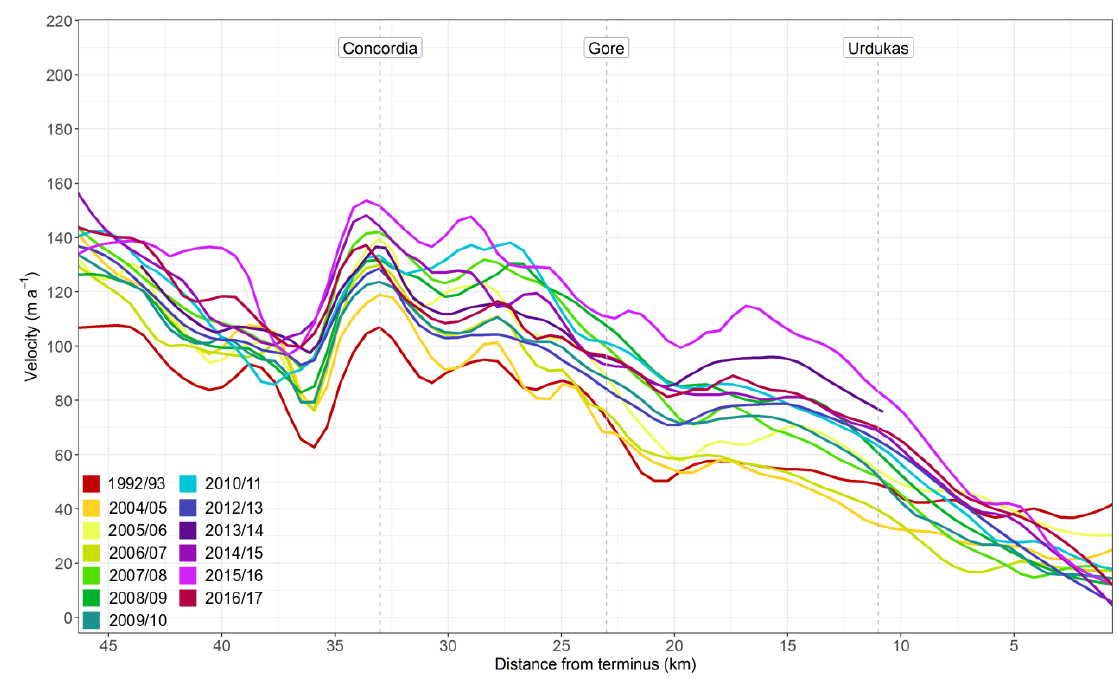
Figure 4. Averaged winter surface velocities (m a − 1 ) along the glacier’s centerline. The averaged summer and winter velocities indicate how seasonal velocities varied since